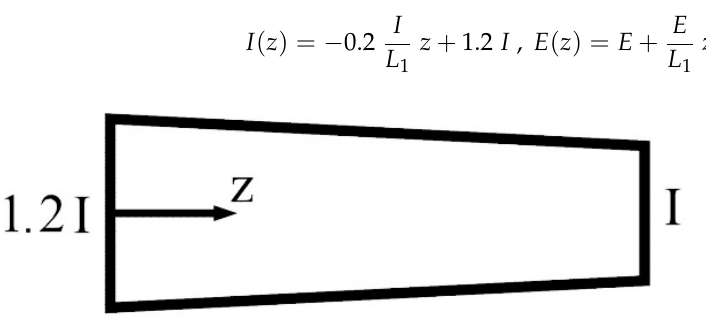
Figure 13. The variation of the moment of inertia of the elements AB and DC (see Figure 12a). For L 1 = 12 m, m i θ is calculated using Equation (62) as follows.